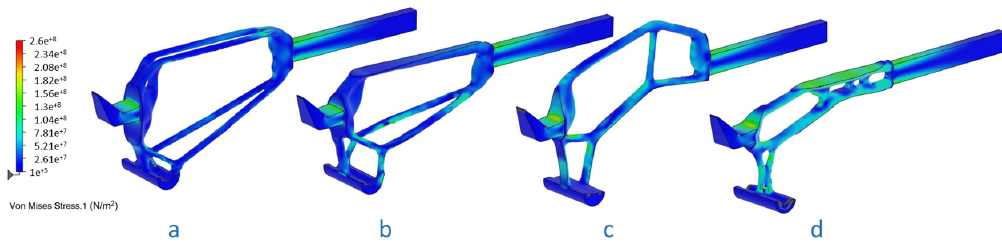
Figure 8. Concepts generated from TO results starting from the enlarged ( a ), the top-limited ( b ), the bottom-limited ( c ) and the fully limited ( d ) design spaces.